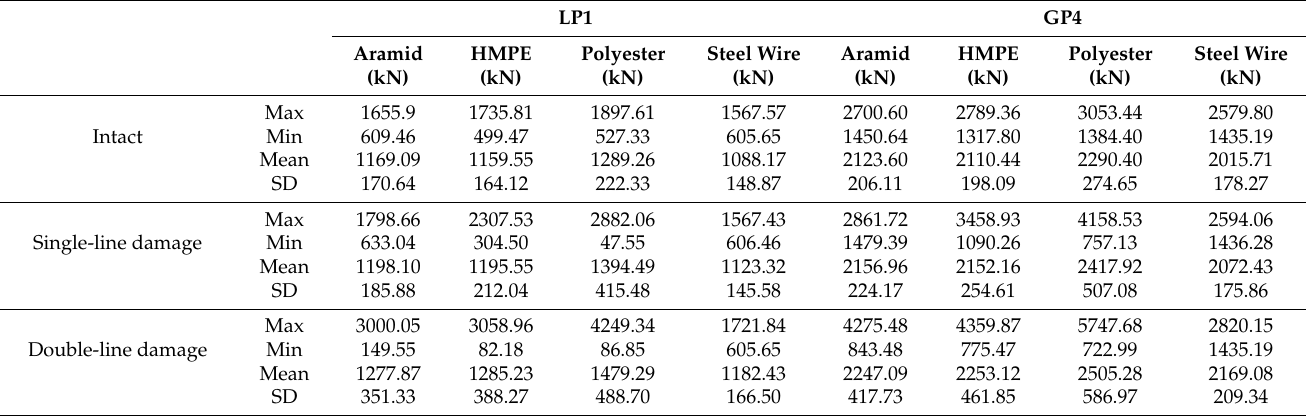
Table 10. Comparison of tension variation of representative risers considering different mooring materials in intact and damaged